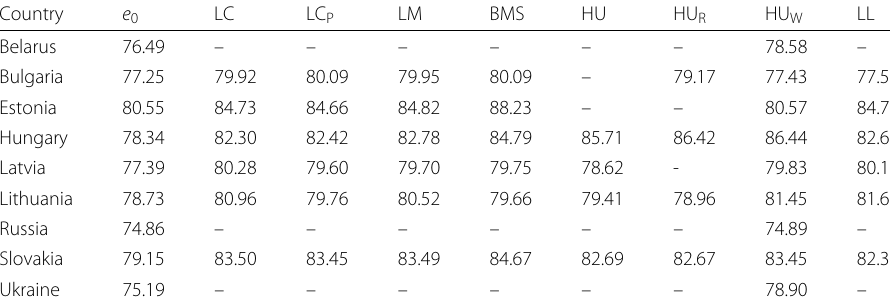
Results are shown for females only. e 0 is life expectancy at birth of 2010 from the HMD. A blank place means 40-years-ahead forecasts of e 0 was lower than the e 0 of